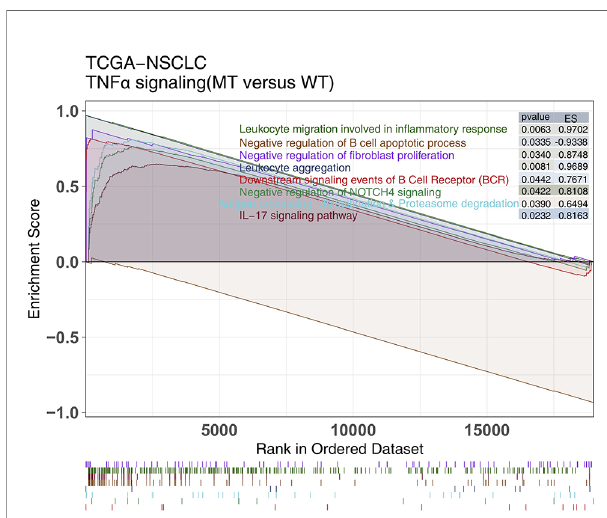
FIGURE 5 | The results of GSEA. The color of the curve corresponds to the font color of the pathway. GSEA of hallmark gene sets downloaded from the MSigDB. Each run was performed with 1000 permutations. Enrichment results with signi fi cant differences between TNF a -MT and TNF a -WT tumors are shown. MSigDB, The Molecular Signatures Database; GSEA, Gene Set Enrichment